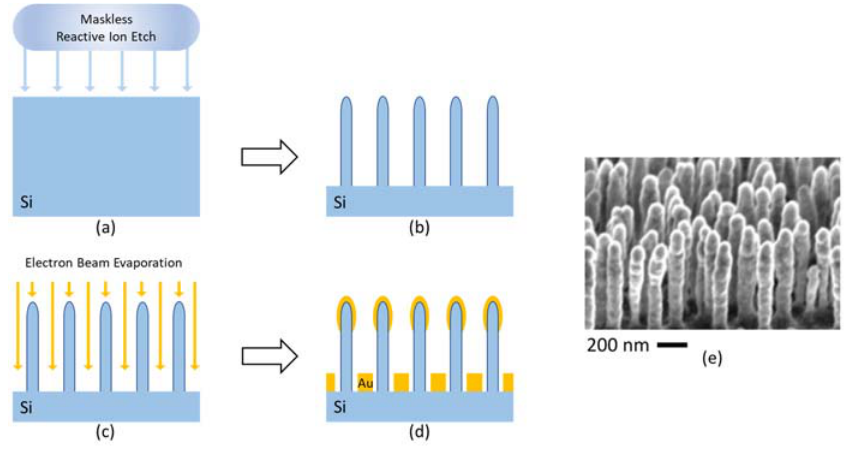
Figure 6. The fabrication process of SERS substrate. ( a , b ) Maskless reactive ion etching forms silicon nanopillars; ( c , d ) Electron beam evaporation forms Au layers; ( e ) SEM image of the nanopillars with coatings [31].